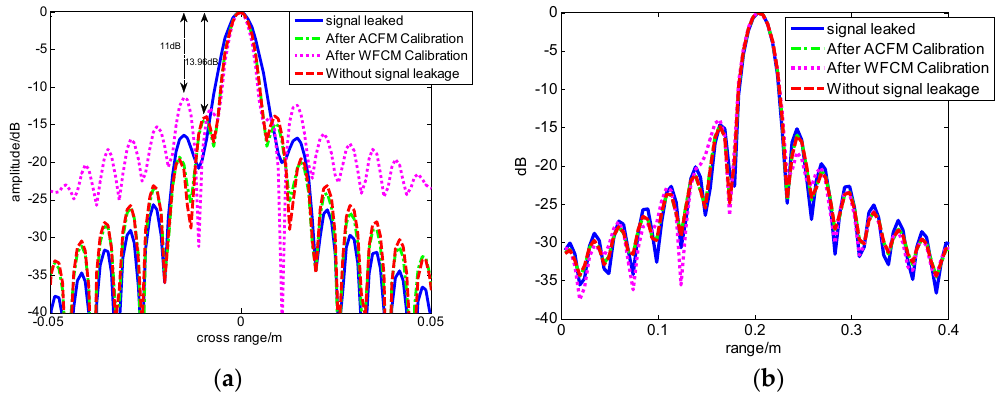
Figure 10. The PSF comparison of different cases in cross range and range, ( a ) is the cross range PSF and ( b ) is the range PSF.